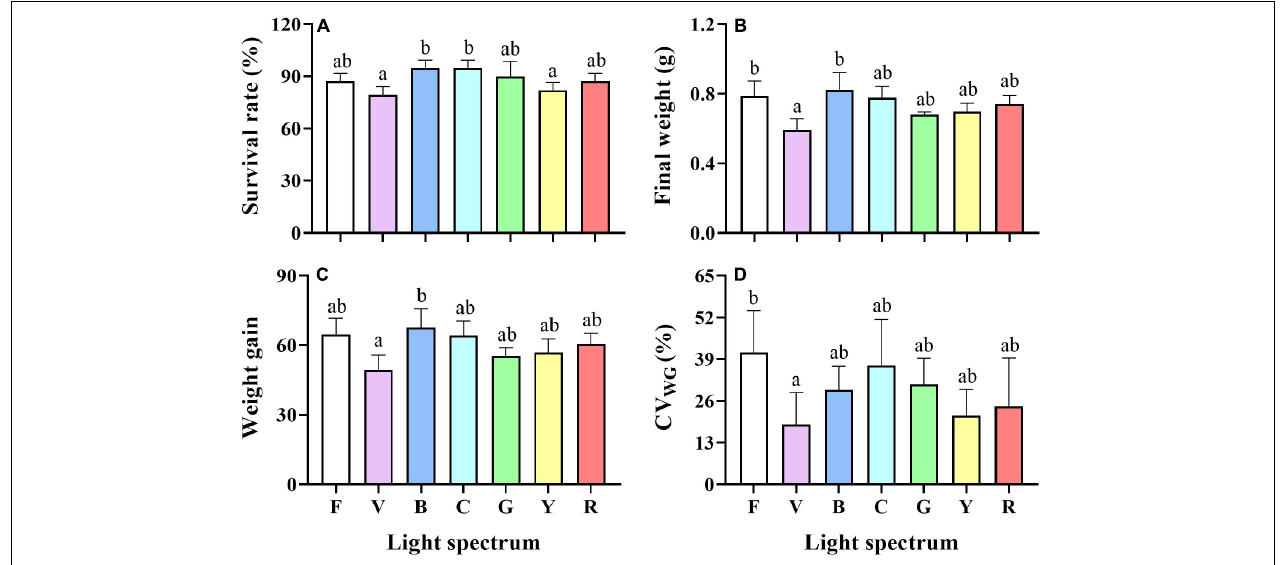
FIGURE 2 | Survival rate (A) , Final weight (B) , Weight gain (C) , coefficient of variation of weight gain (D) of S. paramamosain reared under the different spectra. Values are expressed as means ± SD ( n = 3). F, Full spectrum; V, Violet; B, Blue; C, Cyan; G, Green; Y, Yellow; R, Red. Different superscripts denote significant differences between treatments ( P <